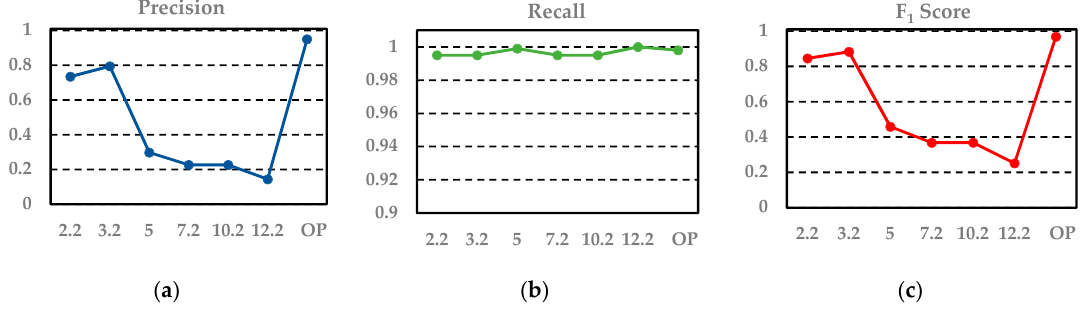
Figure 8. Precision–recall curve under different scales ( a – c ) .